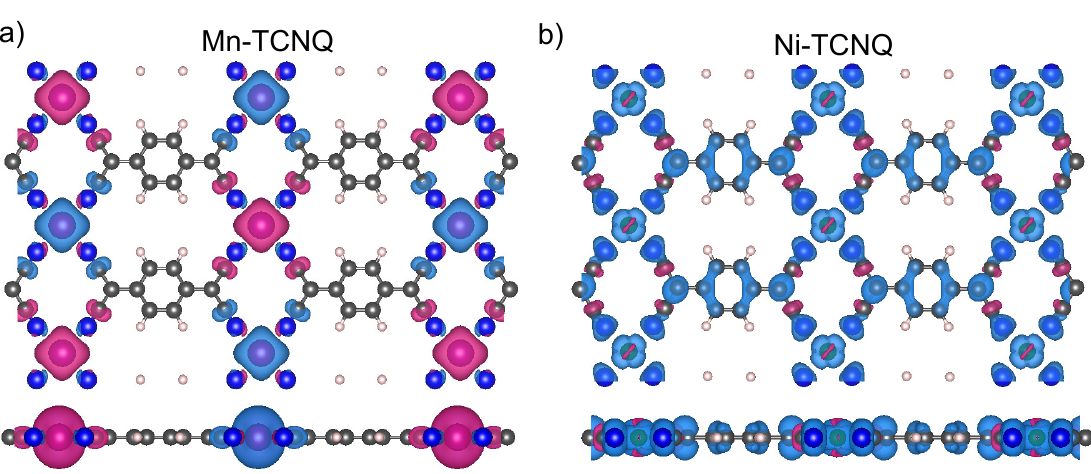
Figure 8. Top (upper panels) and side (lower panels) views of the calculated spin densities for ( a ) Mn–TCNQ and ( b ) Ni–TCNQ free-standing